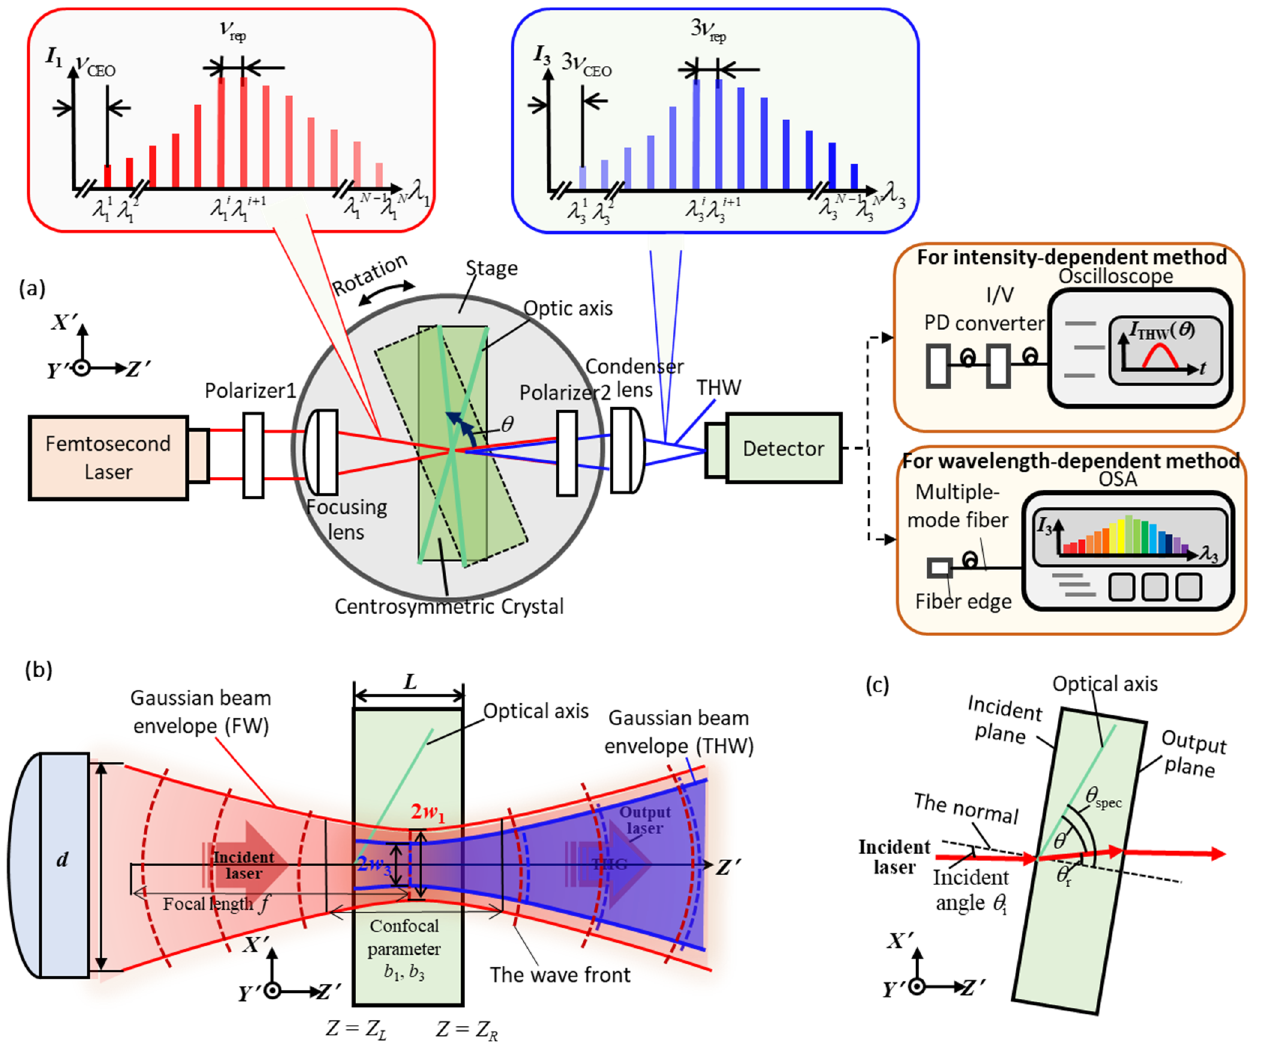
Figure 3. ( a ) The schematic of angle measurement based on direct THG in a centrosymmetric crystal; ( b ) The diagram of THG generated by focused beam; ( c ) The relationship between the incident angle θ i and θ .